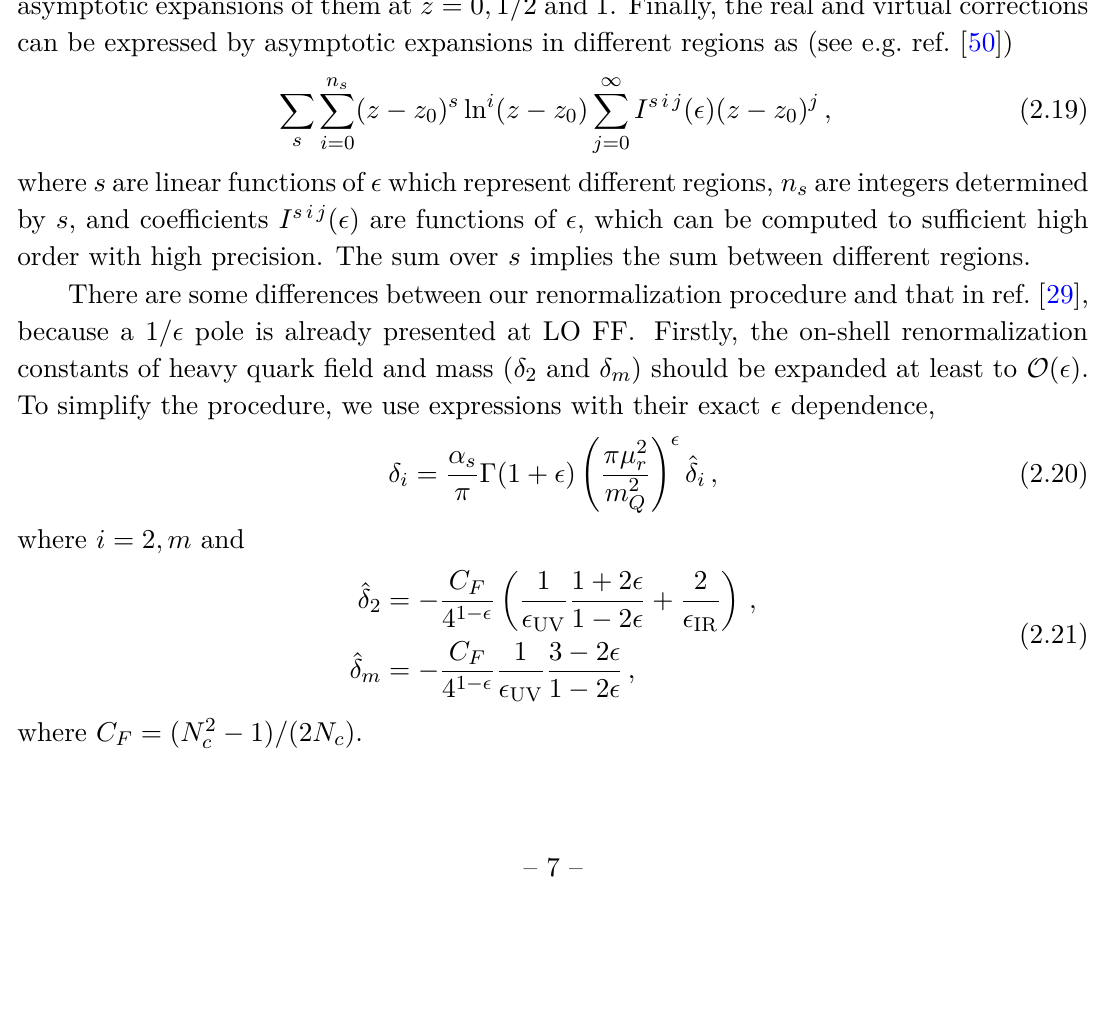
Figure 4 . Real and virtual cut diagrams by cutting at different positions for the last diagrams in figure